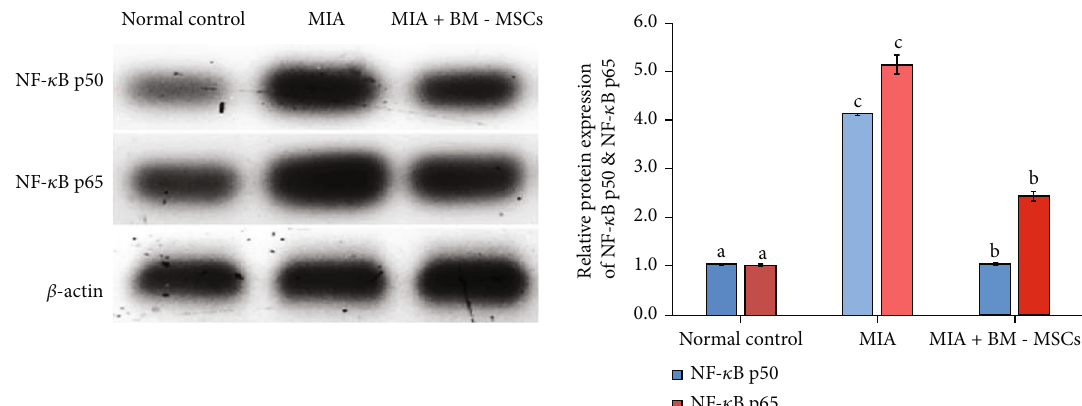
Figure 7: E ff ect of BM-MSC treatment ( 5 × 10 6 cells/rat) on the protein levels of NF- κ B p50 and NF- κ B p65 in MIA-induced animals. Means, which have di ff erent symbols, are signi fi cantly di ff erent at P < 0 : 05 .